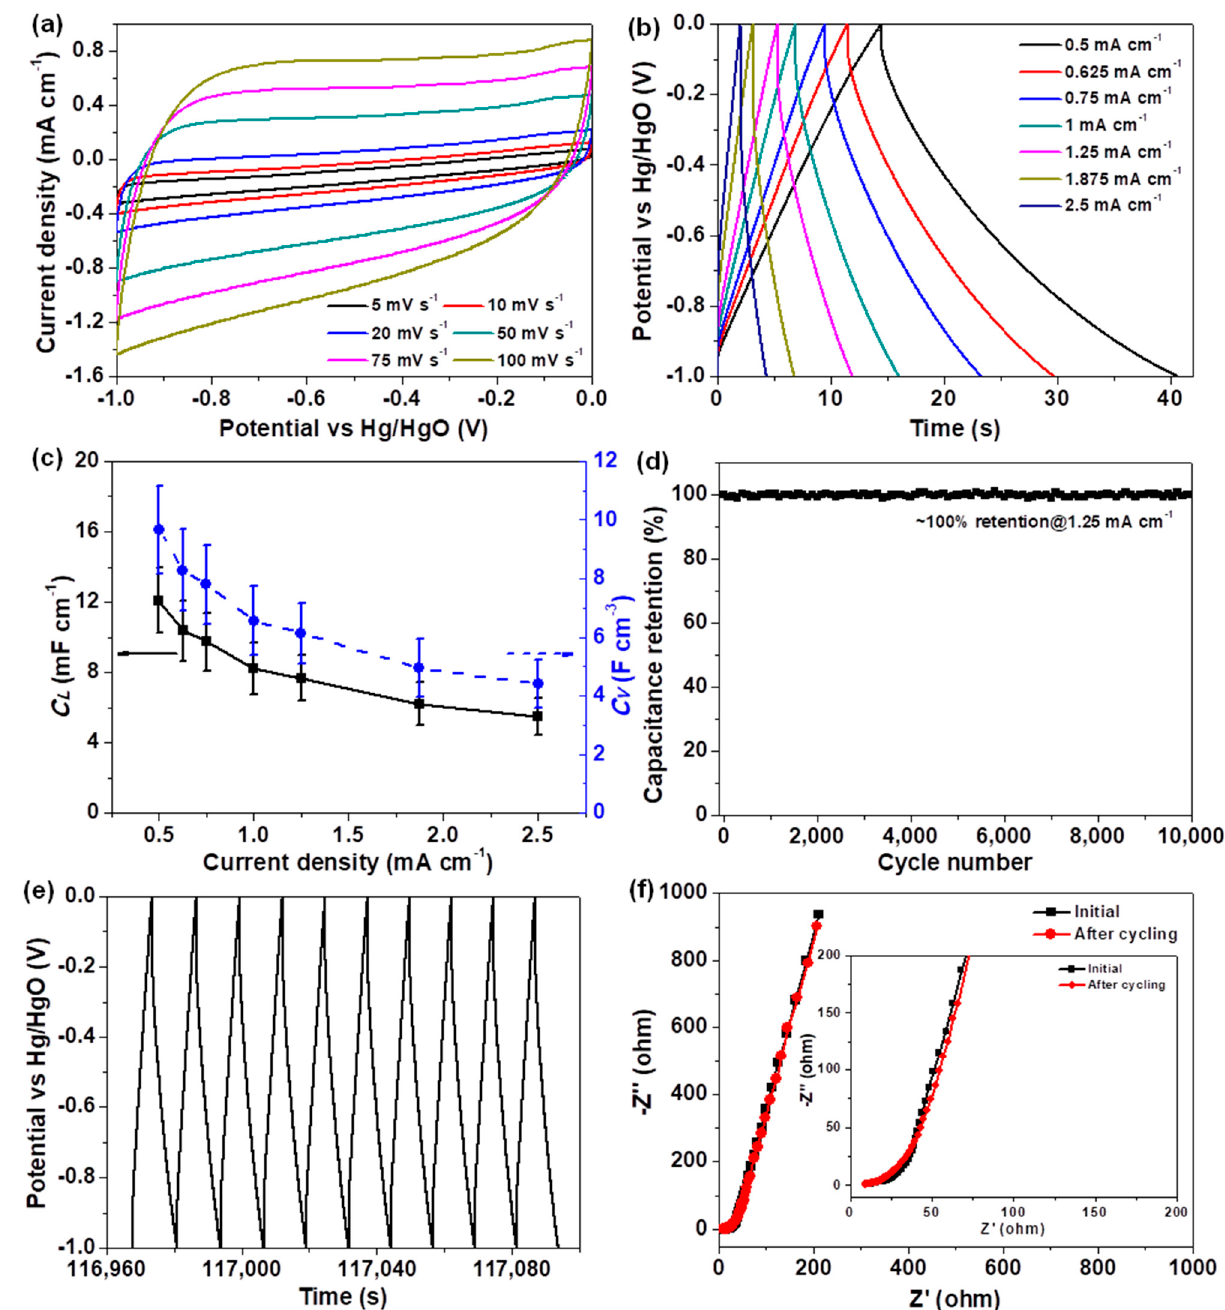
Figure 6. Electrochemical performances of cotton-RGO-AgNP fiber electrode characterized in three-electrode system. ( a ) Its CV curves measured in the range of 5–100 mV·s − 1 . ( b ) Its GCD curves measured in the range of 0.5–2.5 mA·cm − 1 . ( c ) Plot of its linear (C L ) and volumetric (C V ) specific capacitance vs. current density. ( d ) Cyclic performance of this fiber electrode. ( e ) The final 10-cycle GCD curve for the cycling durability test. ( f ) Its initial and post-cycling Nyquist plots with zoomed views of the high-frequency regimes given in the inset.